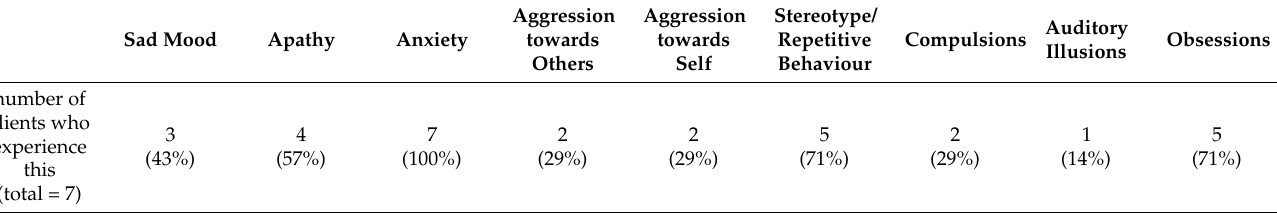
Figure A1. The development of emotional and behavioural symptoms for seven clients, based on the data of Table A1. Note. On the y -axis is ‘frequency times severity’. Table A3. The prevalence of emotional and behavioural symptoms in the set of seven clients.